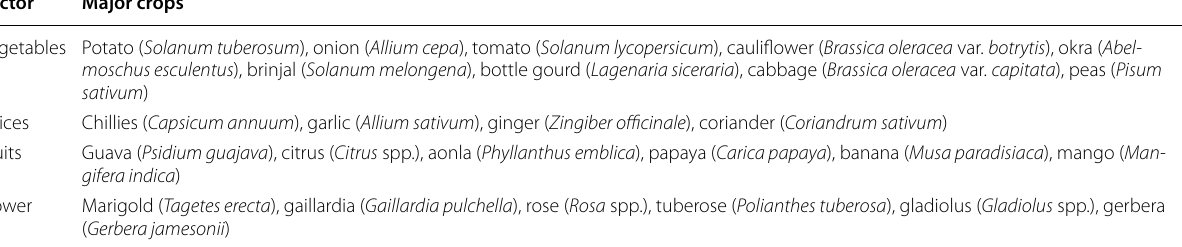
Table 1 The major horticultural crops viz., fruits, vegetables, spices and flowers grown commercially by farmers in Madhya Pradesh state of central India